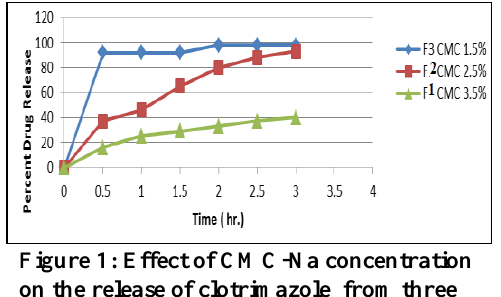
Figure 1: Effect of CMC-Na concentration on the release of clotrimazole from three different formulas.